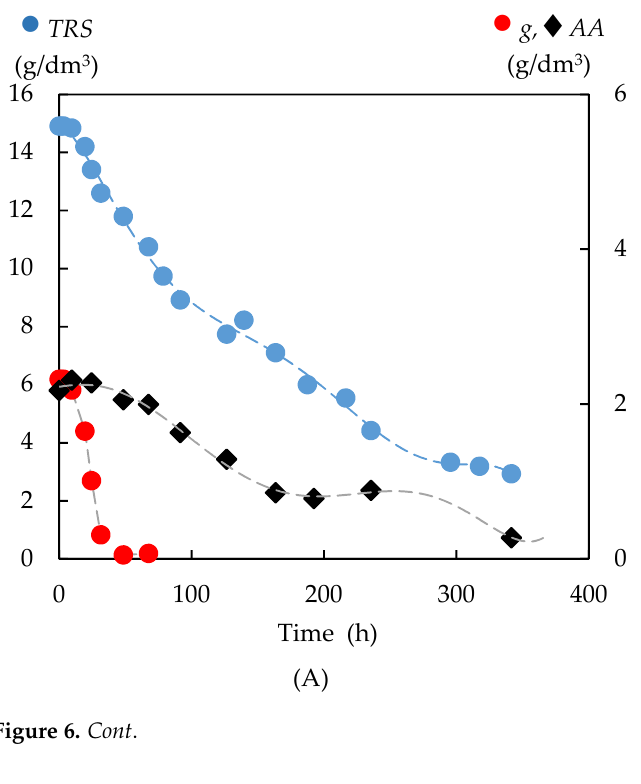
Figure 5. Effect of initial enzyme concentration on Chrastil’s model parameters ( k E , black circles; n , open